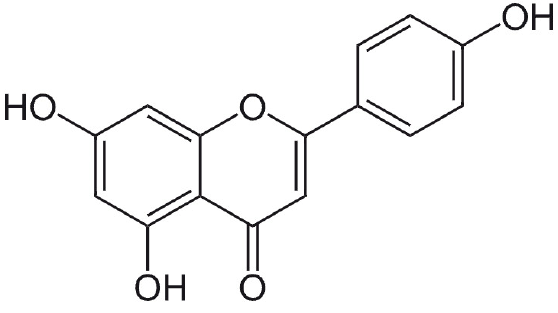
Figure 1. Chemical structure of apigenin.